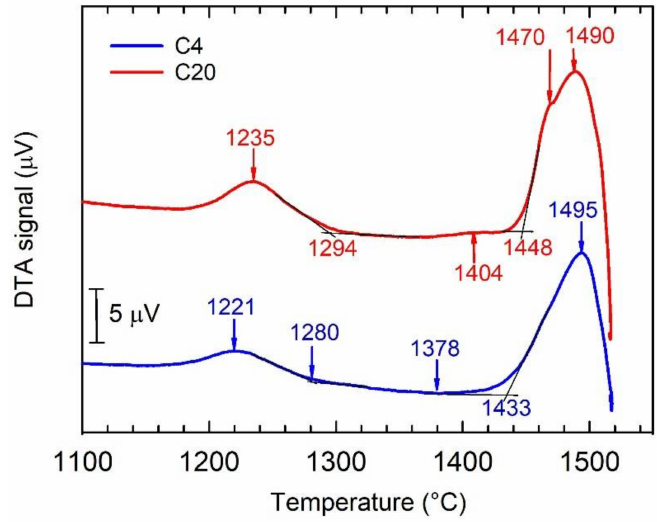
Figure 10. DTA cooling curves for the C4 and C20